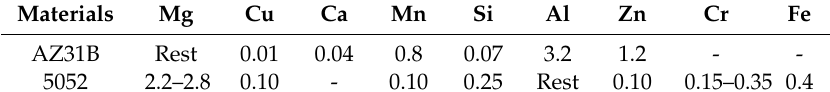
Table 1. Measured chemical compositions (in wt%) of AZ31B and 5052.